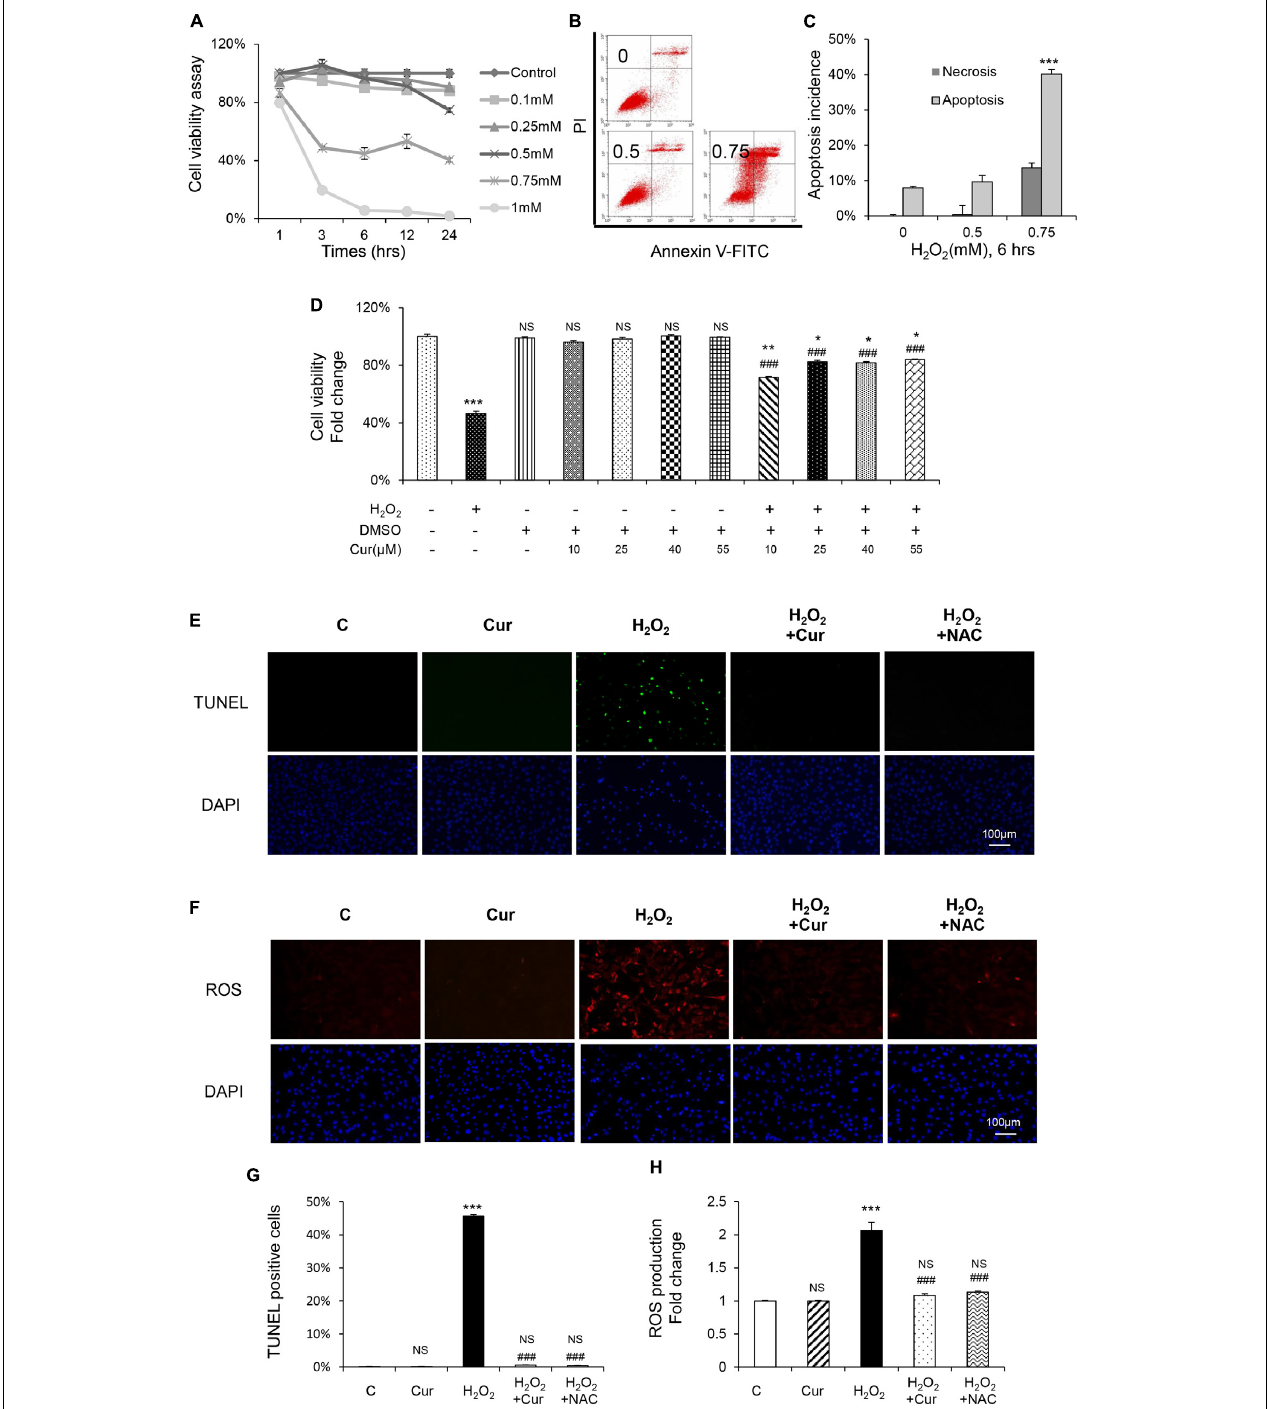
FIGURE 1 | Cur attenuated H 2 O 2 -induced apoptosis and ROS generation in MC3T3-E1 cells. (A) MC3T3-E1 cells were treated with or without H 2 O 2 in the basic medium. Cell viability was determined by MTT reduction in MC3T3-E1 cells in the presence of different concentration of H 2 O 2 for 1, 3, 6, 12, 24 h. (B,C) The flow cytometric analysis of staining from control group, 0.5 and 0.75 mM H 2 O 2 for 6 h. (D) Cur was added 24 h before H 2 O 2 . Cell viability was determined by MTT reduction in MC3T3-E1 cells in the presence of 0.10, 0.25, 0.40, and 0.55 µ M Cur for 24 h with (+) or without (–) H 2 O 2 . (E,G) The cells were immunostained for TUNEL (green). DAPI staining was used to mark the position of the nuclei. Scale bars = 100 µ m. (F,H) The cells were harvested and stained with DCFH-DA (red). Scale bars = 100 µ m. Data are presented as the mean ± SD from at least three independent experiments. * p < 0.05, ** p < 0.01, *** p < 0.001, versus C group; NS, non-significantly different from C group. # p < 0.05, ## p < 0.01, ### p < 0.001, versus the H 2 O 2 group; ns, non-significantly different from H 2 O 2